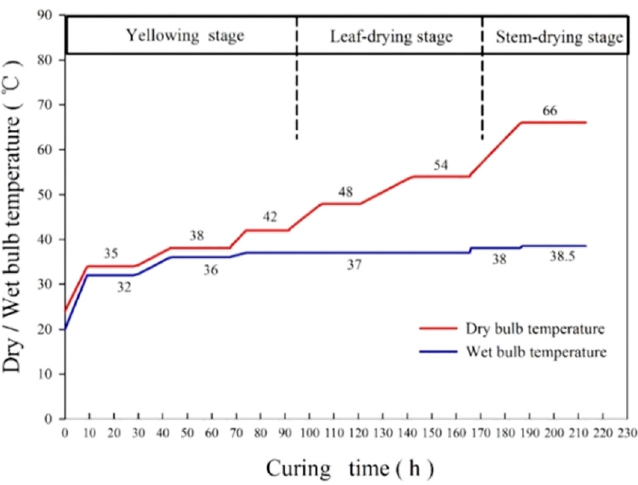
Figure 1. Curing curve of bulk curing barn in NTL growing area. The red and blue lines show the change in dry/wet bulb temperature of roasting with the curing time, respectively. Table 1. The detailed information of Nicotiana tabacum L. (NTL) leaves of different maturity stages is shown in Table 1. Table 1. The detailed information of Nicotiana tabacum L. ( NTL) samples.